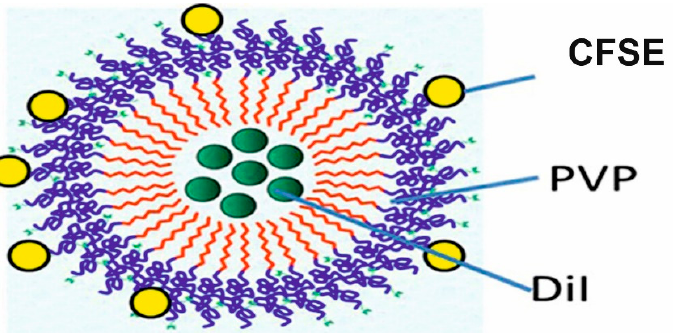
Figure 1. Structure of DNPs. DiI pigment molecules are incorporated into p(VP-AA) NPs, and CFSE (linked CFSE) molecules are attached to p(VP-AA) NPs.